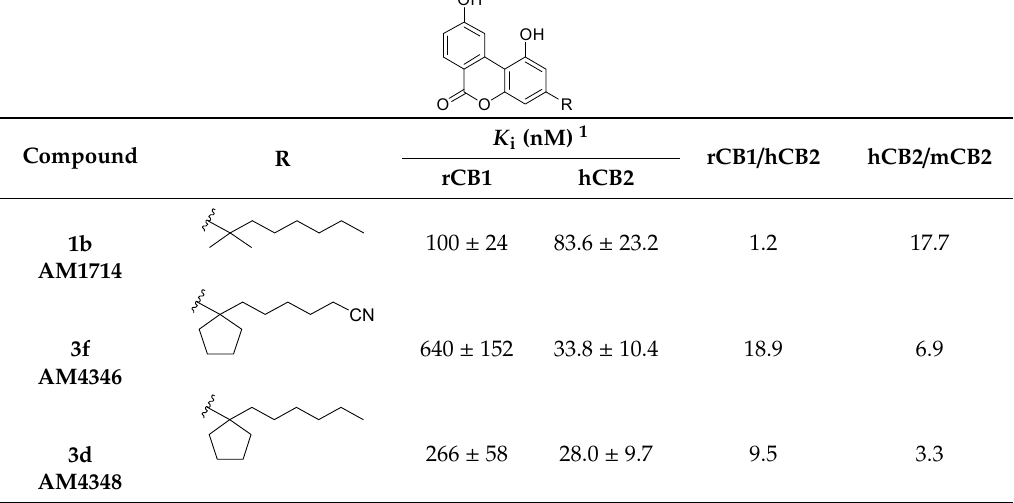
expressing the human and not the mouse protein. Binding affinities were determined, and data were analyzed as for Table 1. Affinities for rCB1 (from Table 1) are included for comparison.